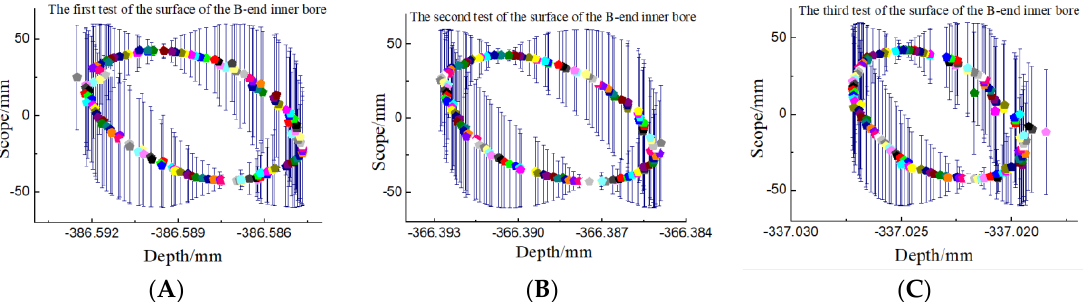
Figure 8. Data diagram of three tests at end A of workpiece. ( A ) First test; ( B ) second test, and ( C ) third test.